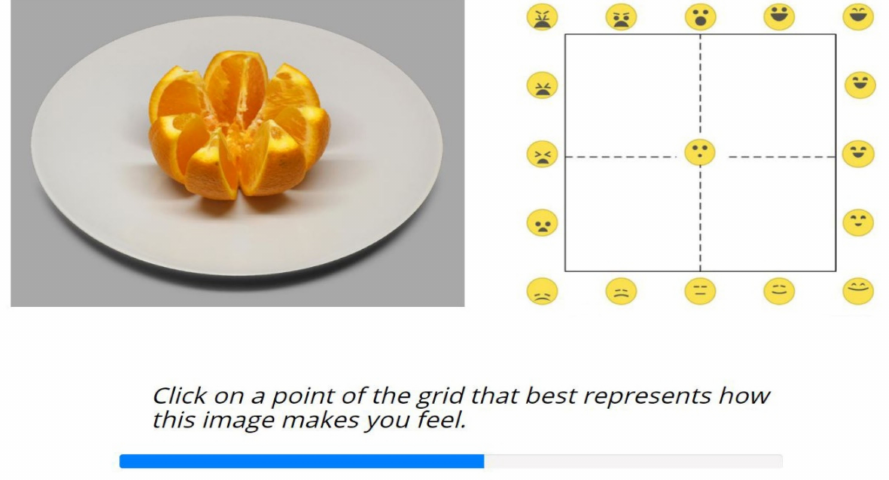
Figure 6. Screen layout of the Image2Grid task: mapping food images to the EmojiGrid. A blue progress bar indicated the progression of the task.